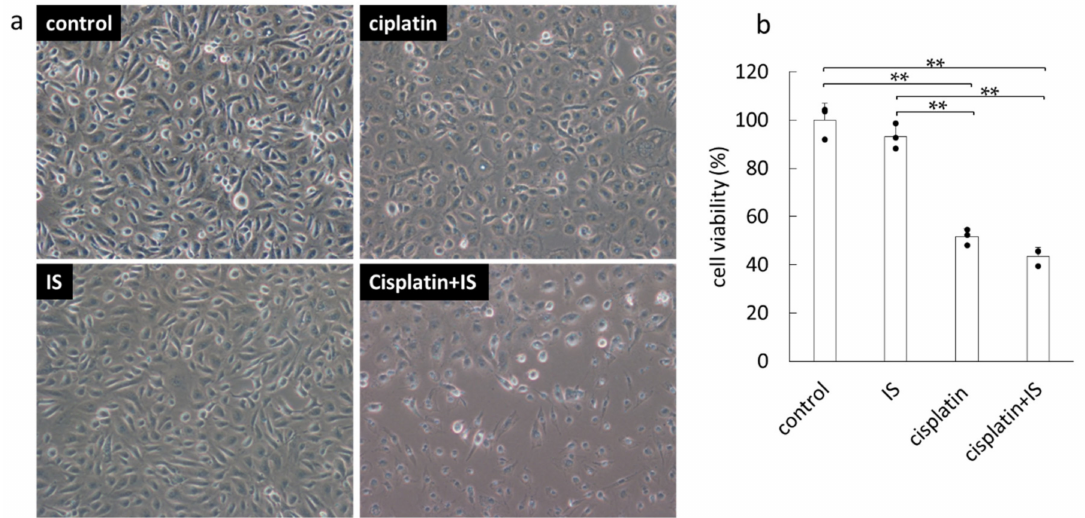
Figure 5. Effect of treatment with cisplatin and/or IS on HK-2 cells: ( a ) appearance of HK-2 cells and ( b ) cell survival rates after 24 h treatment with or without cisplatin (5 µ g/mL) and/or IS (500 µ M). Each column represents the mean ± S.D. of triplicate samples. ** p < 0.01; N.S., not significant.